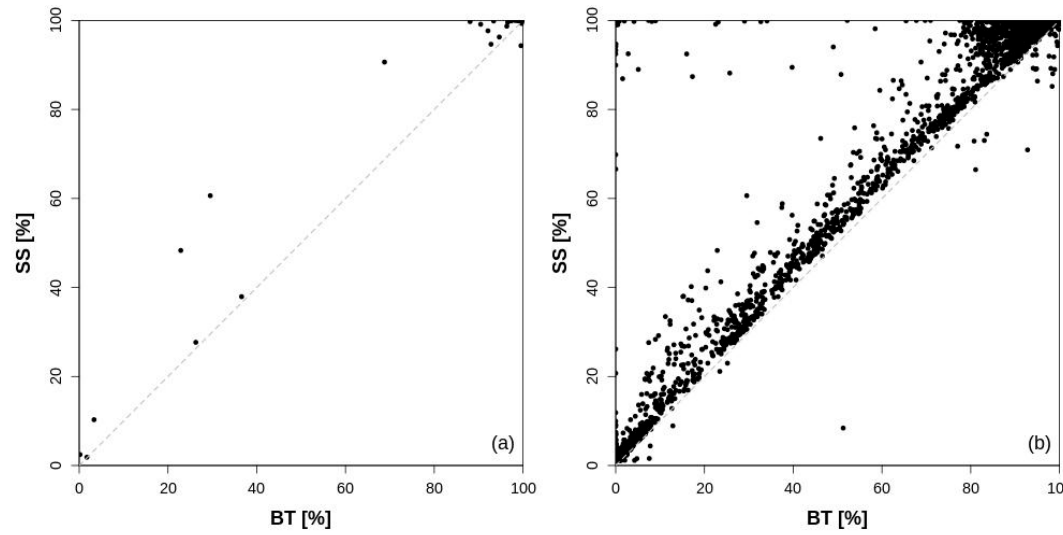
Figure 4. Performance of Blue Thresholding (BT) algorithm versus the Spectral Similarity (SS) method considering only the test dataset ( a ). Comparison between the two methods considering the complete dataset ( b ).